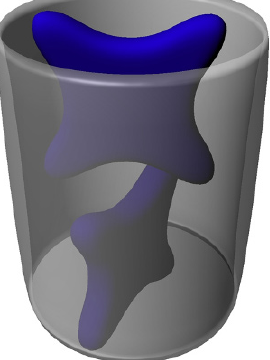
Figure 11. Model of 3 molecule inside of MCM-41